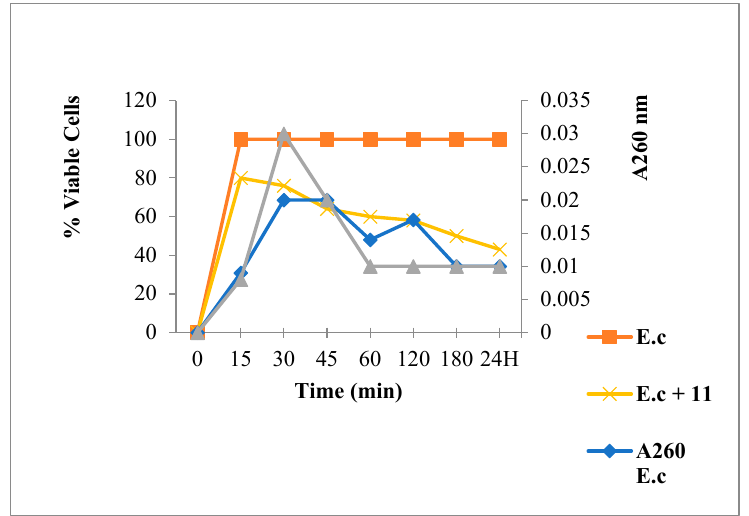
Figure 10. 260 nm absorbent material release and E. coli viability following Flavone 11 treatment.